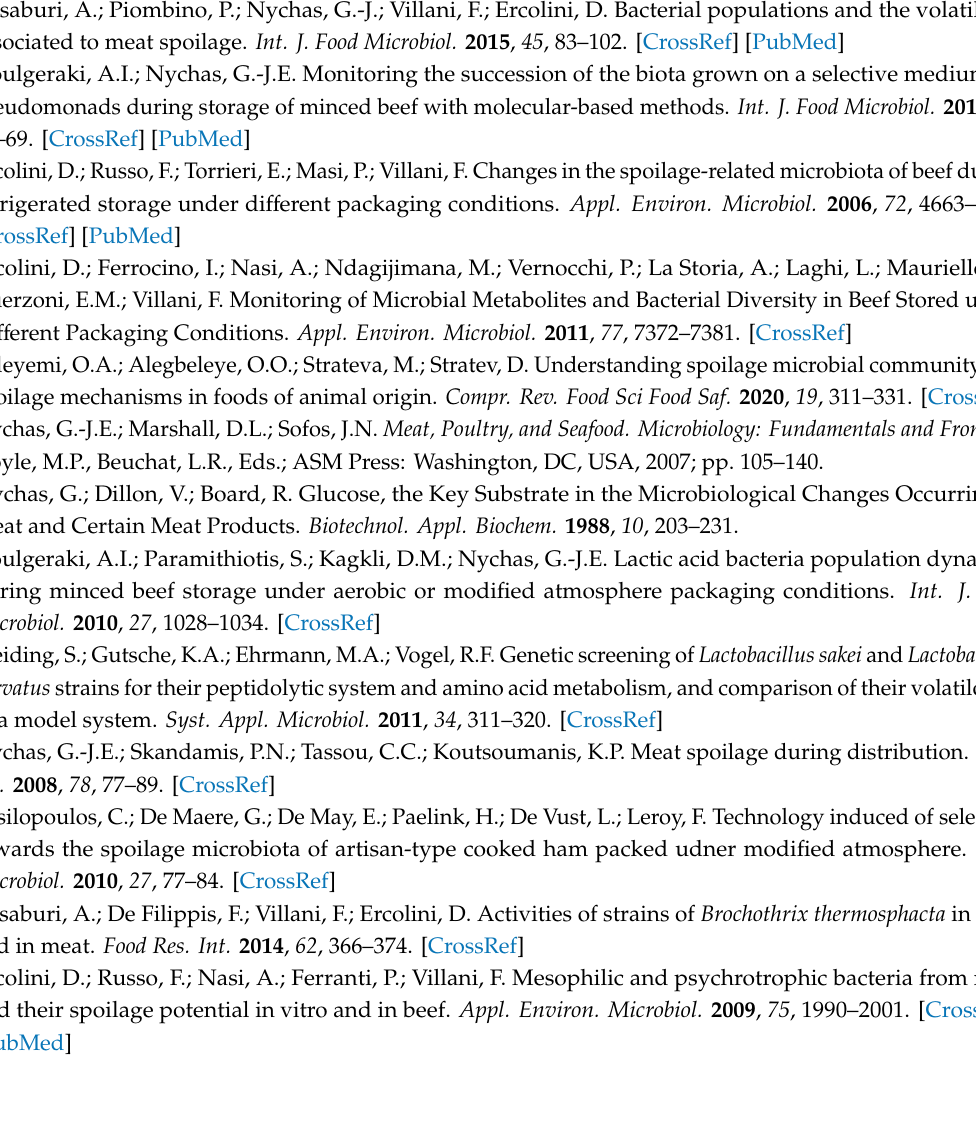
Figure S2: Dendrogram obtained after Ward-linkage clustering based on the Euclidean correlation coe ffi cients of the 51 volatiles identified for the sterile meat and meat inoculated with mono and dual cultures of pseudomonads. The description of the coded treatments is referred to in Table